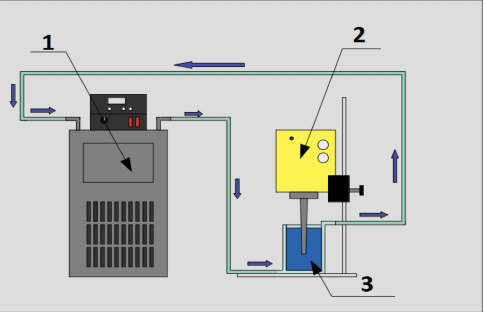
Figure 2. Experimental setup of the sonication process: (1) Refrigerated circulating bath, (2) ultrasonic probe Dr. Hielscher GmbH model UP50H and (3) sample in double jacketed